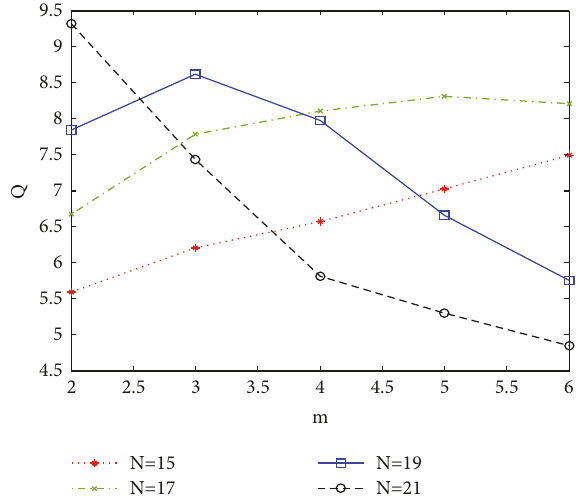
Figure 7: Trend of controllability of BA scale-free network with the number of new edges added to each node 𝑚 varying across 2, 3,. .. ,6 . The controllability of the network when 𝑁 = 15,17,19, 21 .